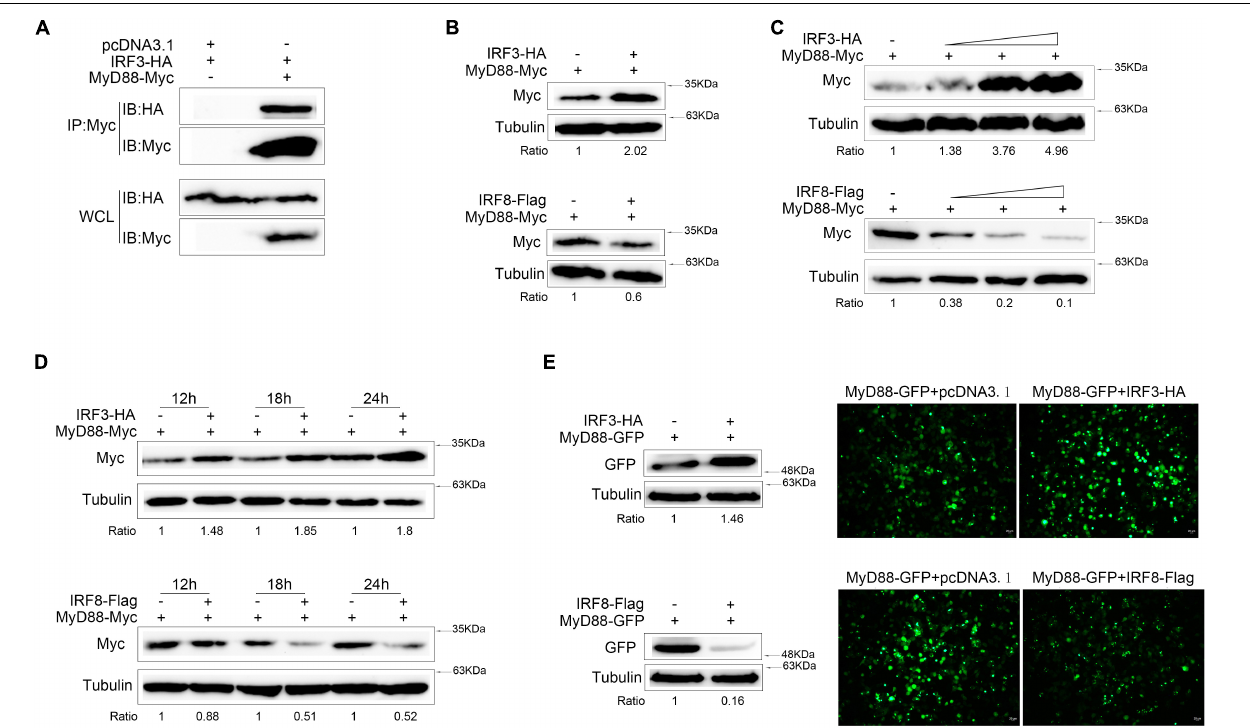
FIGURE 3 | MyD88 expression was regulated by IRF3 and IRF8. (A) HEK293 cells were seeded in 10-cm 2 dishes and cotransfected with 2 µ g of pcDNA3.1 or 2 µ g of IRF3 together with 3 µ g of MyD88. After 24 h post transfection, cell lysates were immunoprecipitation (IP) with Myc antibody, and then immunoprecipitates and whole-cell lysate (WCL) were analyzed by immunoblot with the Abs indicated. (B) Epithelioma papulosum cyprini (EPC) cells were seeded in 12-well plates and transfected with 0.4 µ g of MyD88-Myc together with 0.4 µ g of pcDNA3.1, IRF3-HA, or IRF8-Flag for 24 h. Then, MyD88 was concluded by immunoblot assays and normalized to Tubulin. (C) The concentration experiment of 0.4 µ g of pcDNA3.1, IRF3 (0.1, 0.2, or 0.4 µ g), or IRF8 (0.1, 0.2, or 0.4 µ g) plasmid together with 0.4 µ g of MyD88 was conducted in EPC cells, and MyD88 was concluded by immunoblot assays. (D) The time gradient experiment of 0.4 µ g of pcDNA3.1, IRF3, or IRF8 plasmid together with 0.4 µ g of MyD88 was conducted in EPC cells, and MyD88 was concluded by immunoblot assays. (E) HEK293 cells were seeded in 12-well plates and cotransfected the 0.4 µ g of IRF3 or IRF8 plasmid with 0.4 µ g of MyD88-GFP. After 24 h post transfection, the fluorescence signals of MyD88-GFP were detected by fluorescence microscopy (right), and then MyD88 was determined by immunoblot assays (left). All experiments were performed in at least three independent